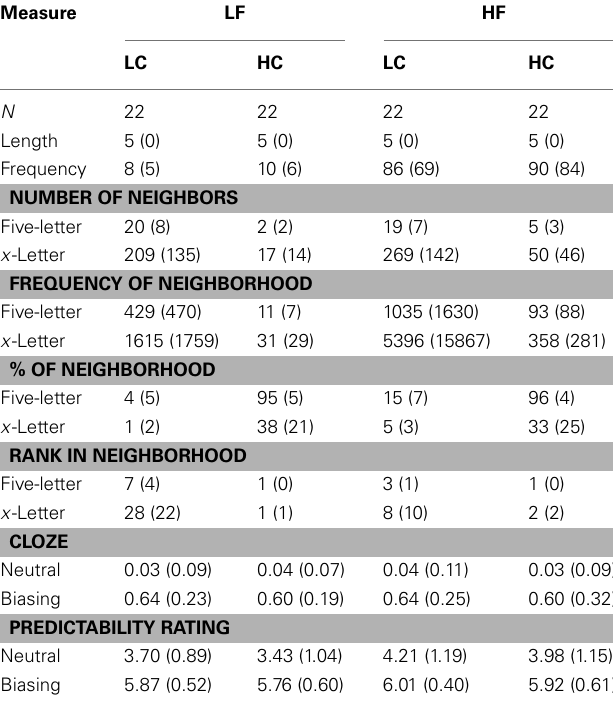
Table 2 | Means (with SDs) of target specifications across experimental